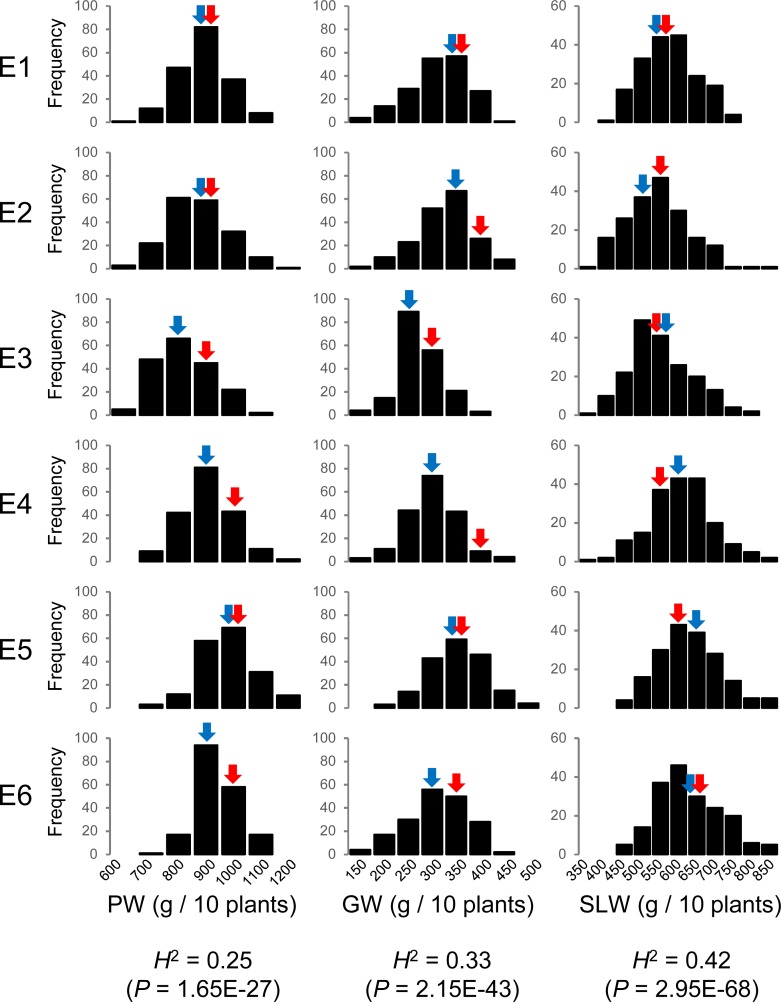
Frequency distributions and broad-sense heritabilities (H2) of biomass-related traits in RILs over multiple environments.Blue arrow, mean of ‘Tachisugata’; red arrow, mean of ‘Hokuriku 193’. E, environment; PW, plant weight; GW, grain weight; SLW, stem and leaf weight.